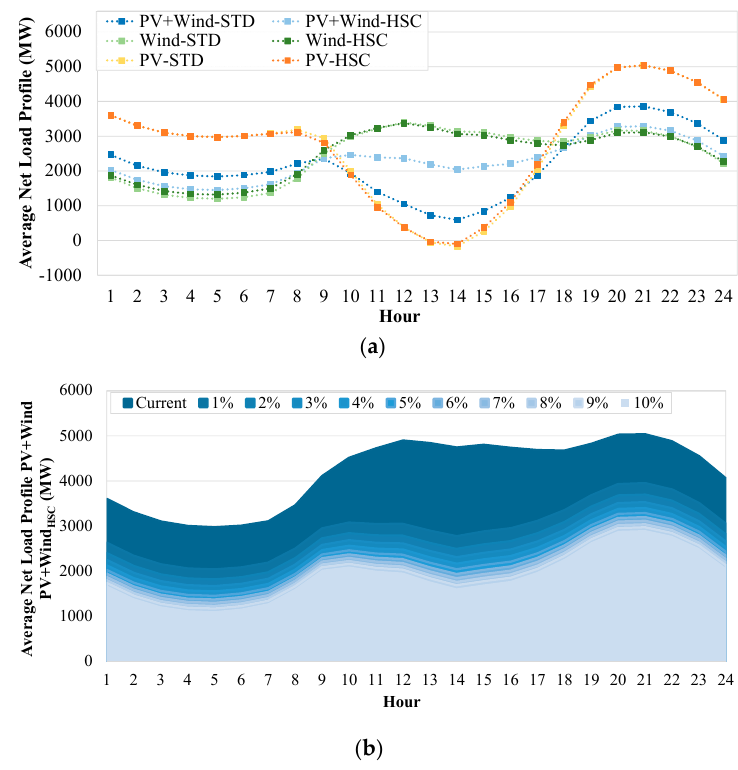
Figure 9. Daily profile for ( a ) all scenarios using a Surplus (cid:2923)(cid:2911)(cid:2934). equal to 5%, and ( b ) the net load observed in the PV + Wind HSC scenario for different Surplus (cid:2923)(cid:2911)(cid:2934). values.